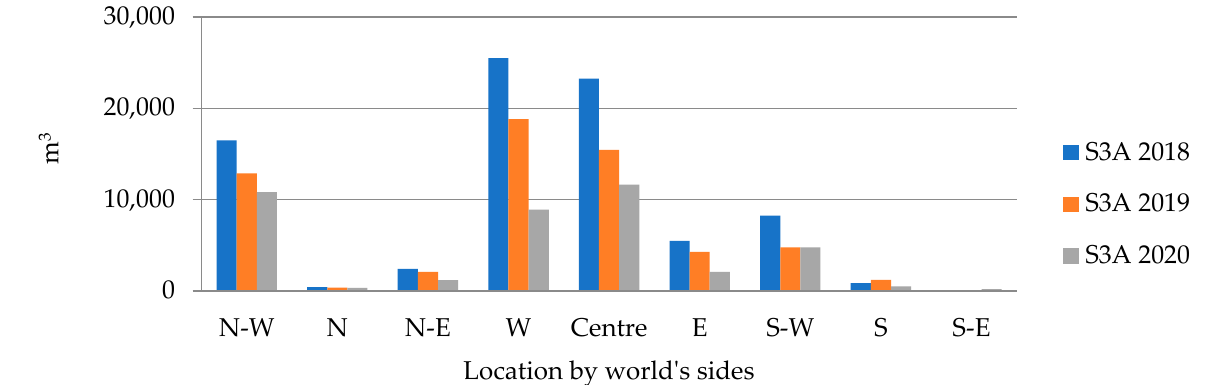
Figure 7. The amount of S3A medium-sized perch wood harvested in Poland between 2018 and 2020. Own elaboration based on the available data.